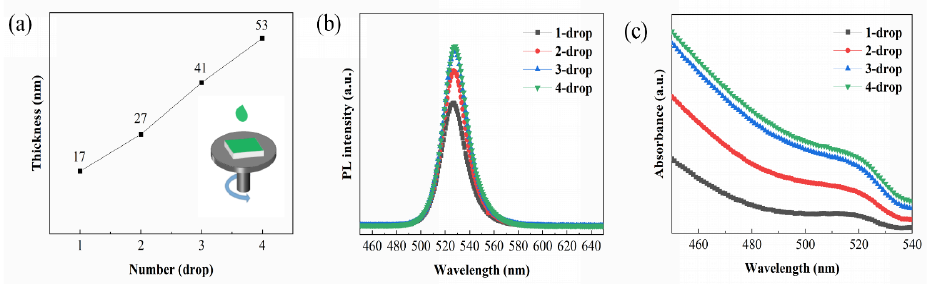
Figure 2. ( a ) The thicknesses of the perovskite layers, ( b ) Photoluminescence spectra, and ( c ) Absorption spectra of the thin films formed by dynamic spin coating of the FAPb 0.7 Sn 0.3 Br 3 nanocrystalline solution with different dosages of droplets on ITO/PEDOT:PSS/TFB.